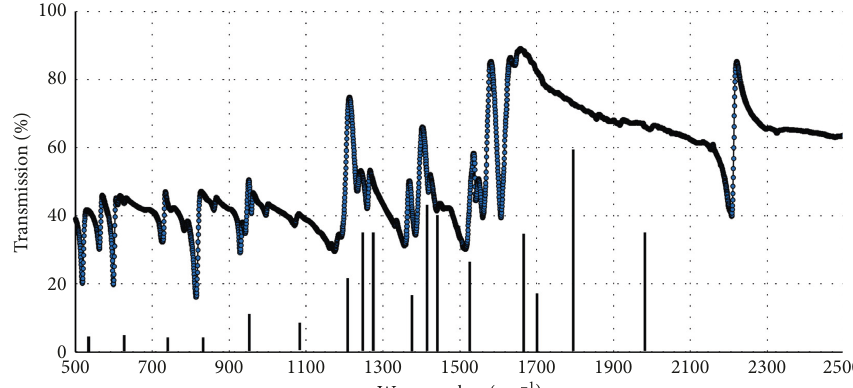
Figure 3: FTIR in KBr (continuous curve) and Gaussian-shaped IR spectrum of geometrically optimized BMN in the gaseous phase (rectangular stick lines).